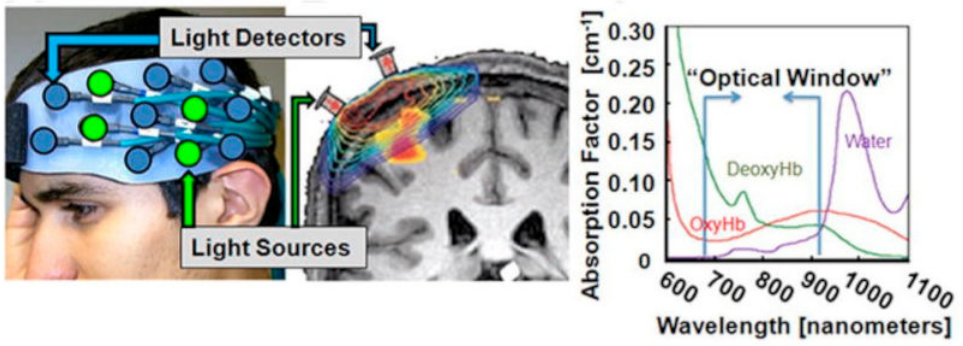
Figure 1. Example of how an emitter–detector pair works along with the optical window looked at to refine the data. (Reprinted with permission from ref. [6] (Copyright 2012 Elsevier)). Available online: https://www.sciencedirect.com/science/article/abs/pii/S0966636211004115?via%3Dihub (accessed on 9 September 2021).